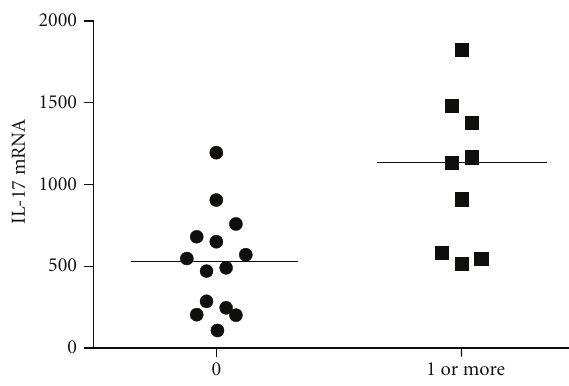
F 1: SputumIL-17AmRNAlevelsin childrenwith CF.Sputum mRNA was extracted from 23 children with CF aged 5–17 years, as described [47]. IL-17A mRNA levels were measured by real- time RT-PCR [44]. Sputum IL-17A mRNA levels in 9 CF children experiencing at least one exacerbation in the past 12 months (1 or more) were compared to those without exacerbation (